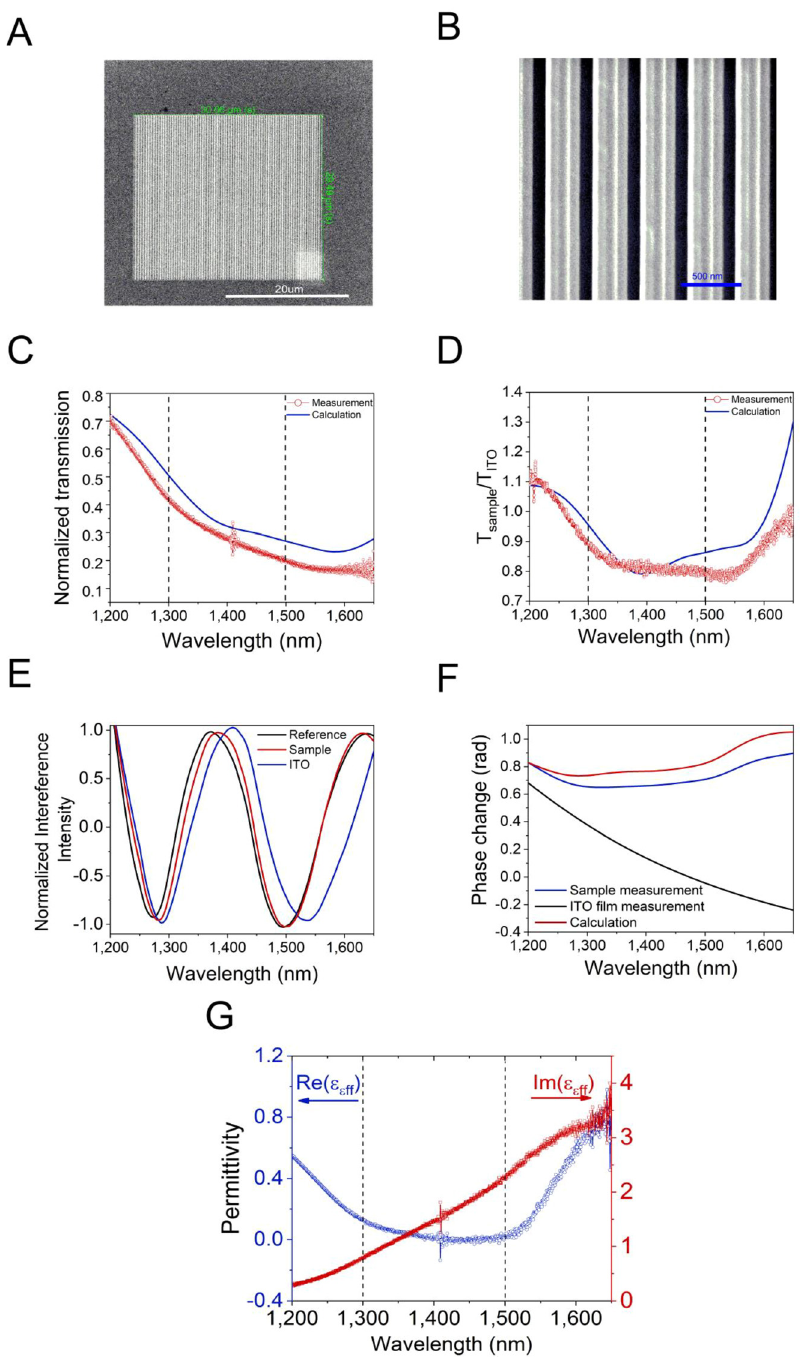
Figure 2: Scanning electron micrograph (SEM) images and optical characteristics of the broadband ENZ response. SEM top-view (A) and magni fi ed (B) images of the structure. The sample is a 30 um × 30 um rectangle and the period is 400 nm. (C) Measured and simulated transmission spectrum of the fabricated ENZ sample. (D) Measured and simulated transmission ratio between the nanostructured ENZ sample and the pure ITO fi lm on the same substrate. (E) Measured normalized interference patterns formed through the light transmitted through the ENZ sample, air hole and ITO fi lm combined with the light transmitted through the reference arm by utilizing the white-light interference, respectively. (F) Extracted phase change of the light transmitting through the ENZ sample, air hole and bare ITO fi lm, respectively. (G) Measured and retrieved effective permittivity for the ENZ material